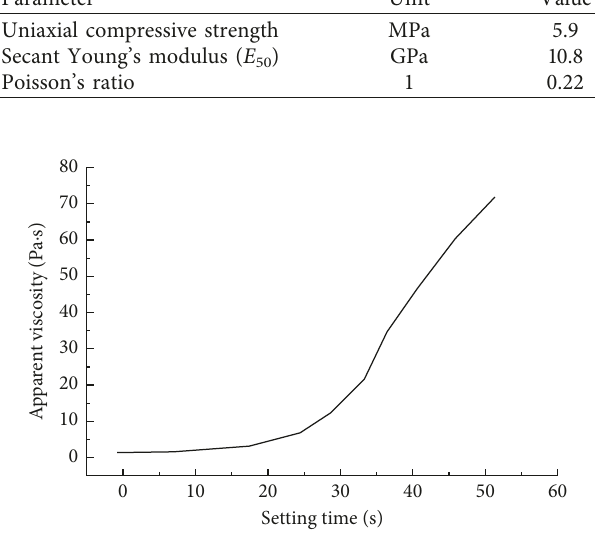
Figure 7: The viscosity versus time curve of cement-sodium silicate